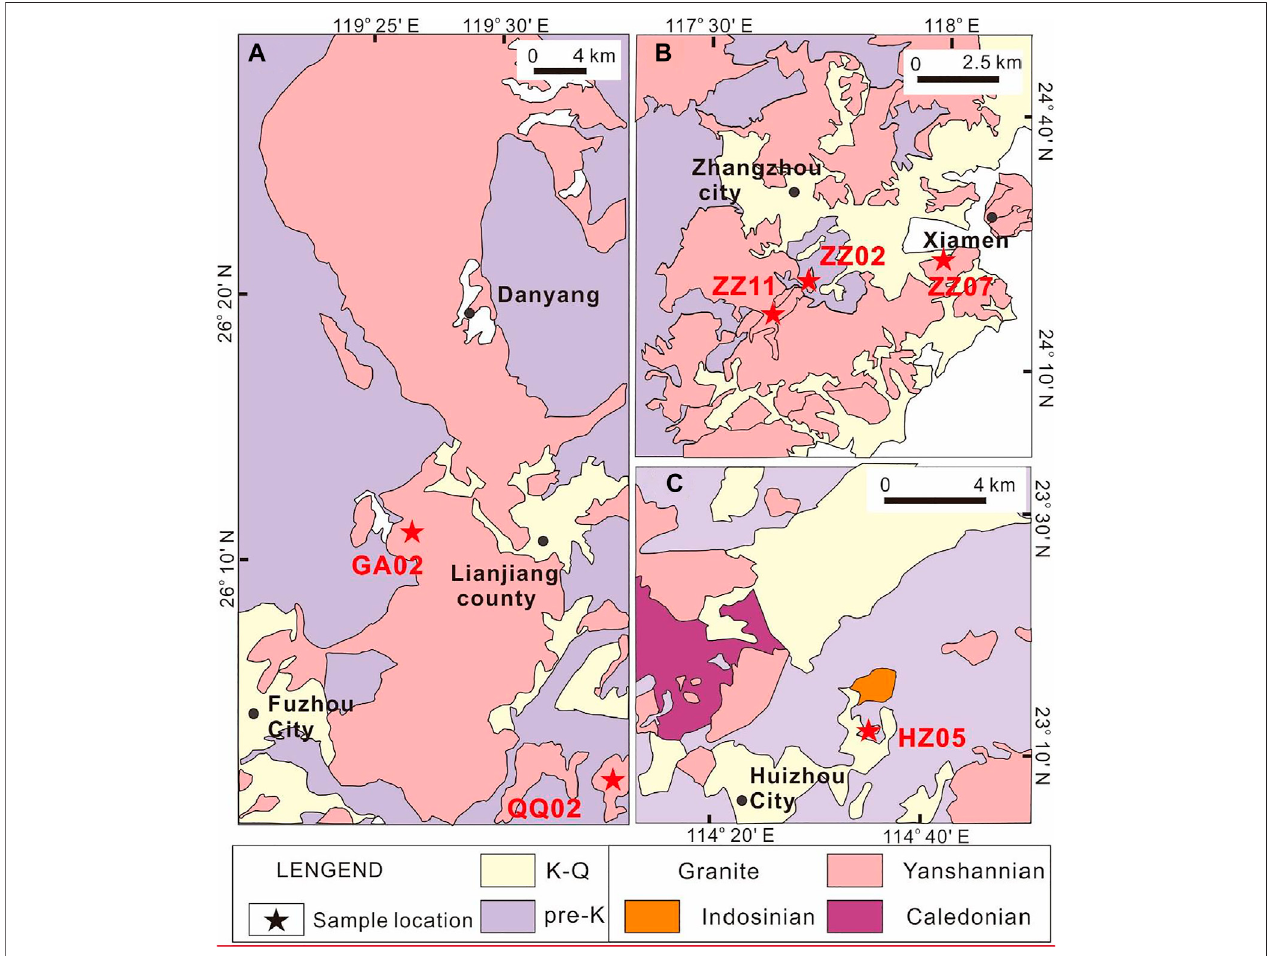
FIGURE 3 | Simpli fi ed geological map of selected regions in Southeast Coastal Area: (A) Fuzhou area; (B) Zhangzhou area; (C) Huizhou area (Modi fi ed after Zhu 2015; Yang 2016; Zhang et al., 2021).